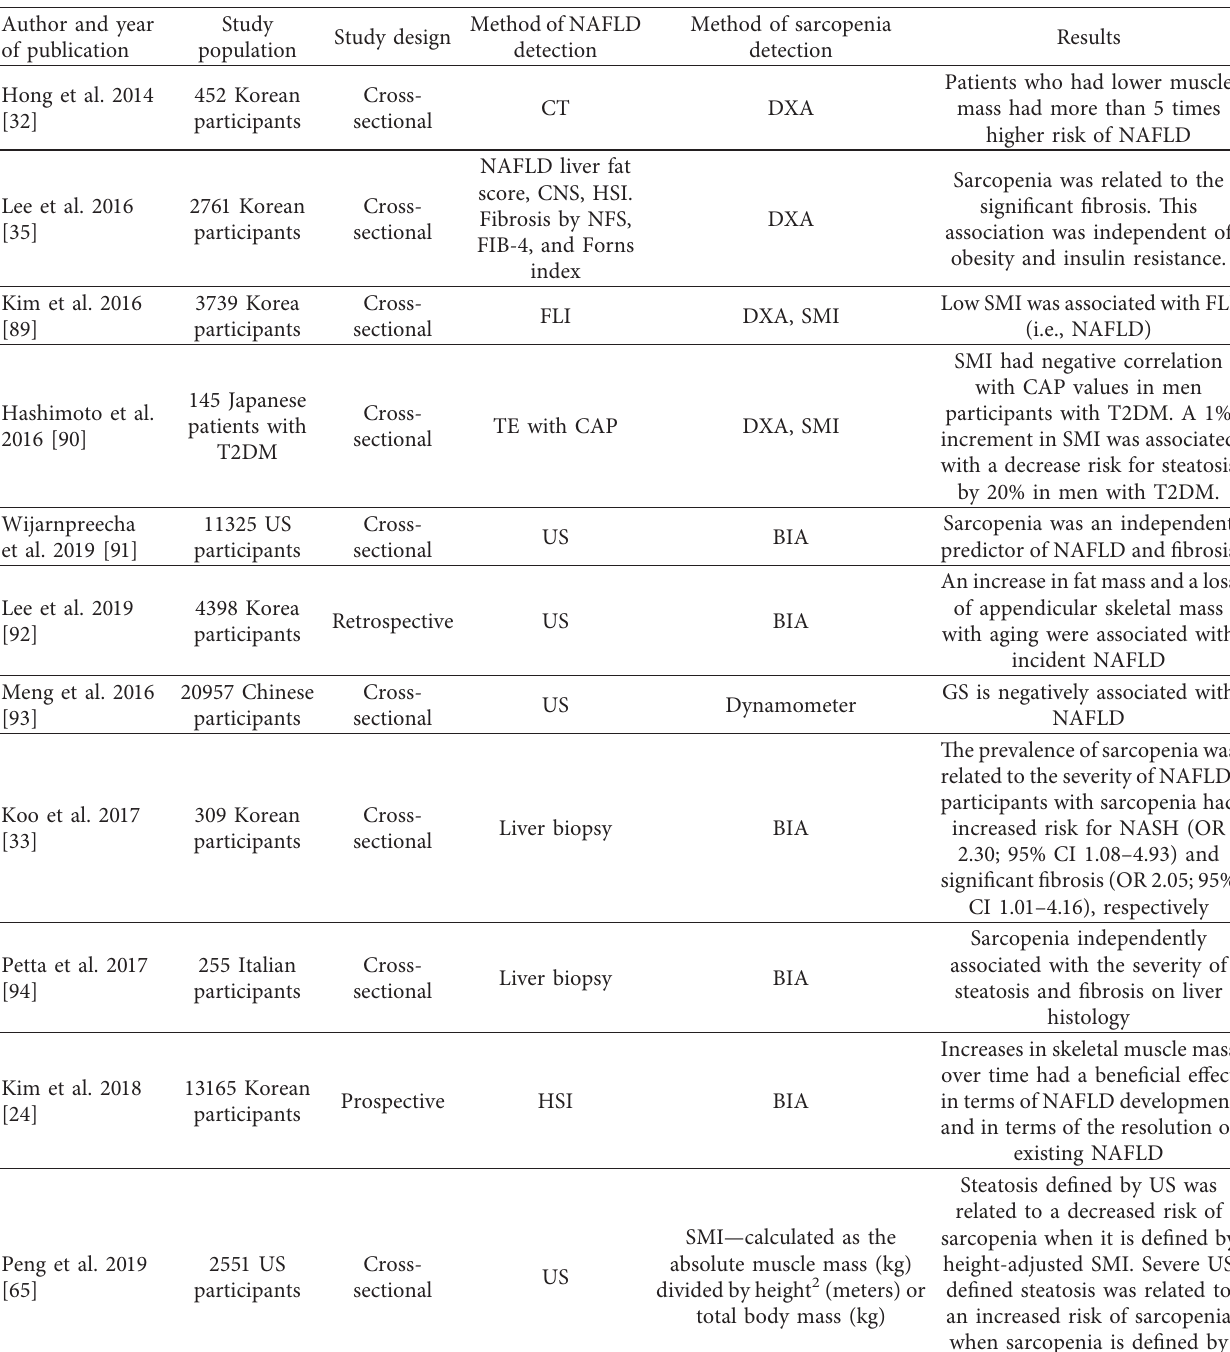
Table 2: Clinical studies linking NAFLD and